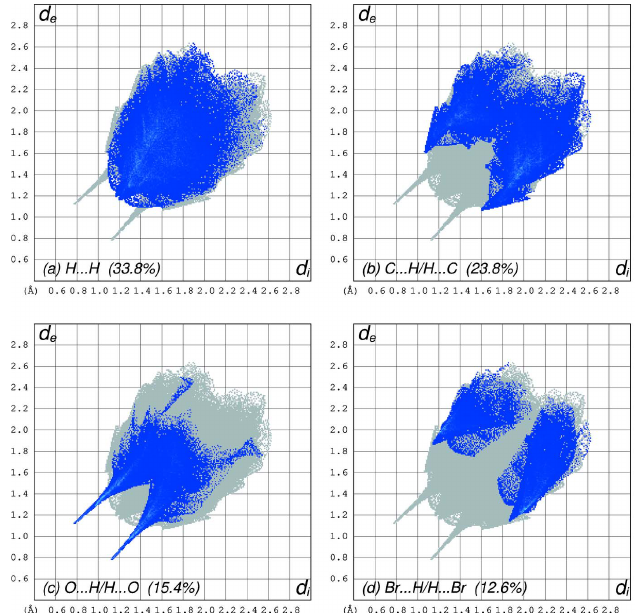
Figure 9 Fingerprint plots obtained from a Hirshfeld surface analysis for II using CrystalExplorer , separated into ( a ) H (cid:2)(cid:2)(cid:2) H (33.8% coverage), ( b ) C (cid:2)(cid:2)(cid:2) H/ H (cid:2)(cid:2)(cid:2) C (23.8%), ( c ) O (cid:2)(cid:2)(cid:2) H/H (cid:2)(cid:2)(cid:2) O (15.4%), ( d ) Br (cid:2)(cid:2)(cid:2) H/H (cid:2)(cid:2)(cid:2) Br (12.6%). All other contacts are negligible.